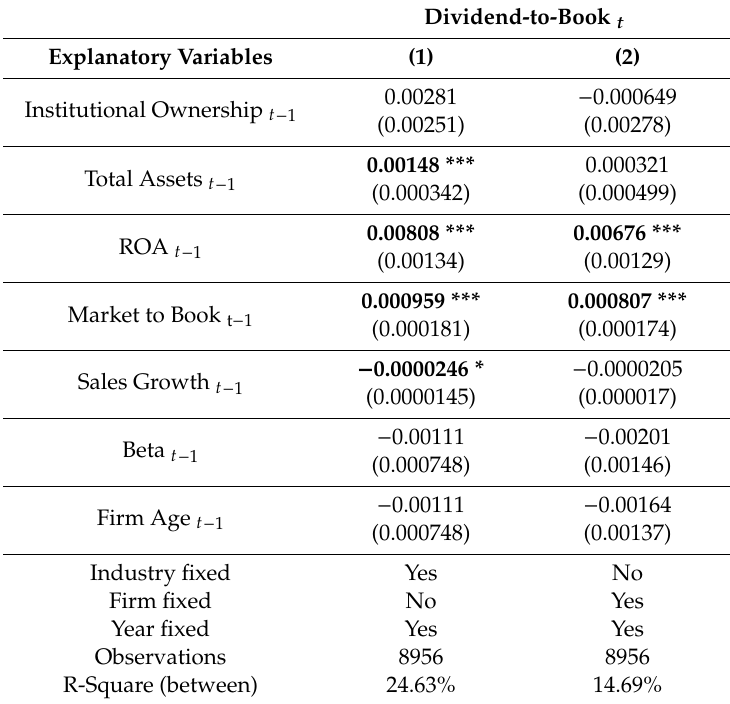
Table 3. E ff ect of % Institutional Holdings on Dividend. This table reports estimates of regressions of dividend payments on institutional holdings. Dividend-to-Book is the annual dividend in year t divided by the book value of assets at the end of year t. Institutional ownership is the sum of the percentage of outstanding shares owned by the top 20 institutional investors. The control variables are as follows: Total assets is the natural log of total assets, Market-to-Book is the market value of equity to the book value of equity, ROA is the return on assets, sales growth is the one-year percentage change in sales, firm age is the natural logarithm of the firm’s age, measured by the di ff erence between the current year and the year when the firm was listed. We take all these financial variables from Data Analysis Premium. We calculate the beta of a firm by running a regression of the firm’s previous 36 monthly stock excess returns against the market excess returns, where the market return is measured by the ASX all ordinary index returns, and the risk-free rate is the one-month rate on the government bill. The data consist of all Australian listed firms excluding financial or utility companies between 2001 and 2015. We obtain the institutional holdings data from SIRCA. Market indices are from the ASX website, and risk-free rates are from the Australia Reserve Bank website. In model (1), we control for industry-fixed and year-fixed e ff ect. In model (2), we control for firm-fixed and year-fixed e ff ect. The standard errors are clustered at the firm level. The symbols *, **, *** denote significance at the 10%, 5%, and 1% levels,